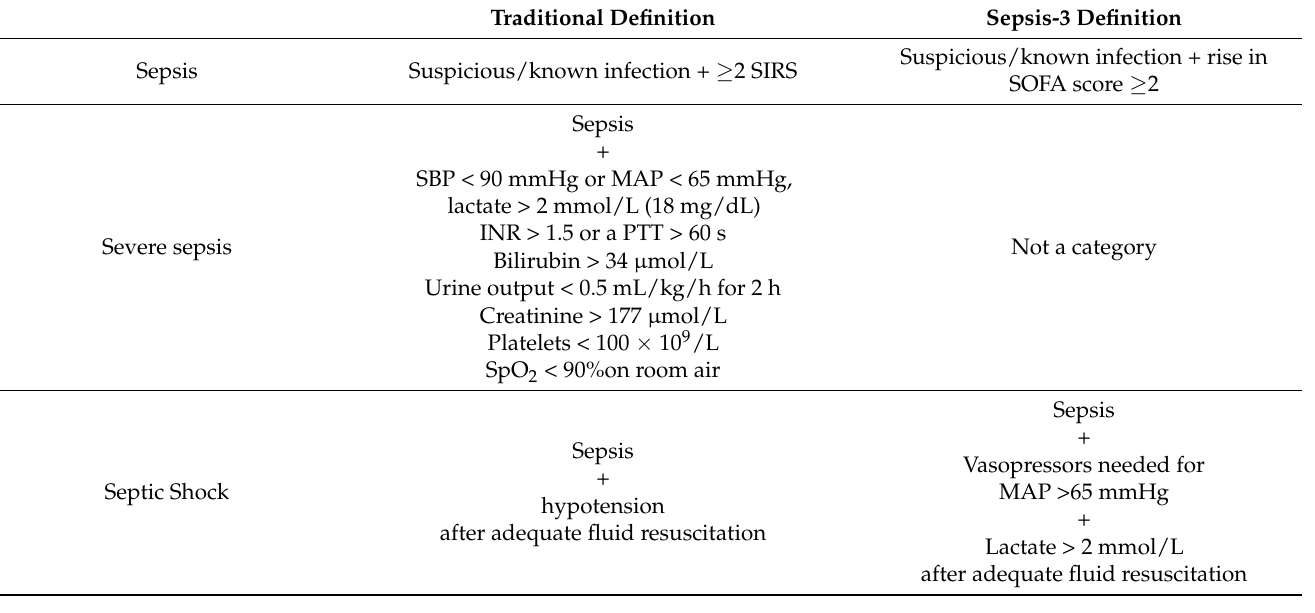
Table 1. Sepsis-3 (revised) definition for sepsis compared with the traditional sepsis definition. Traditional Definition